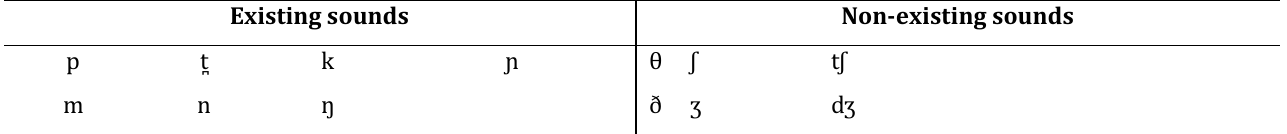
Table 1. Vietnamese final consonants (as compared to English consonantal